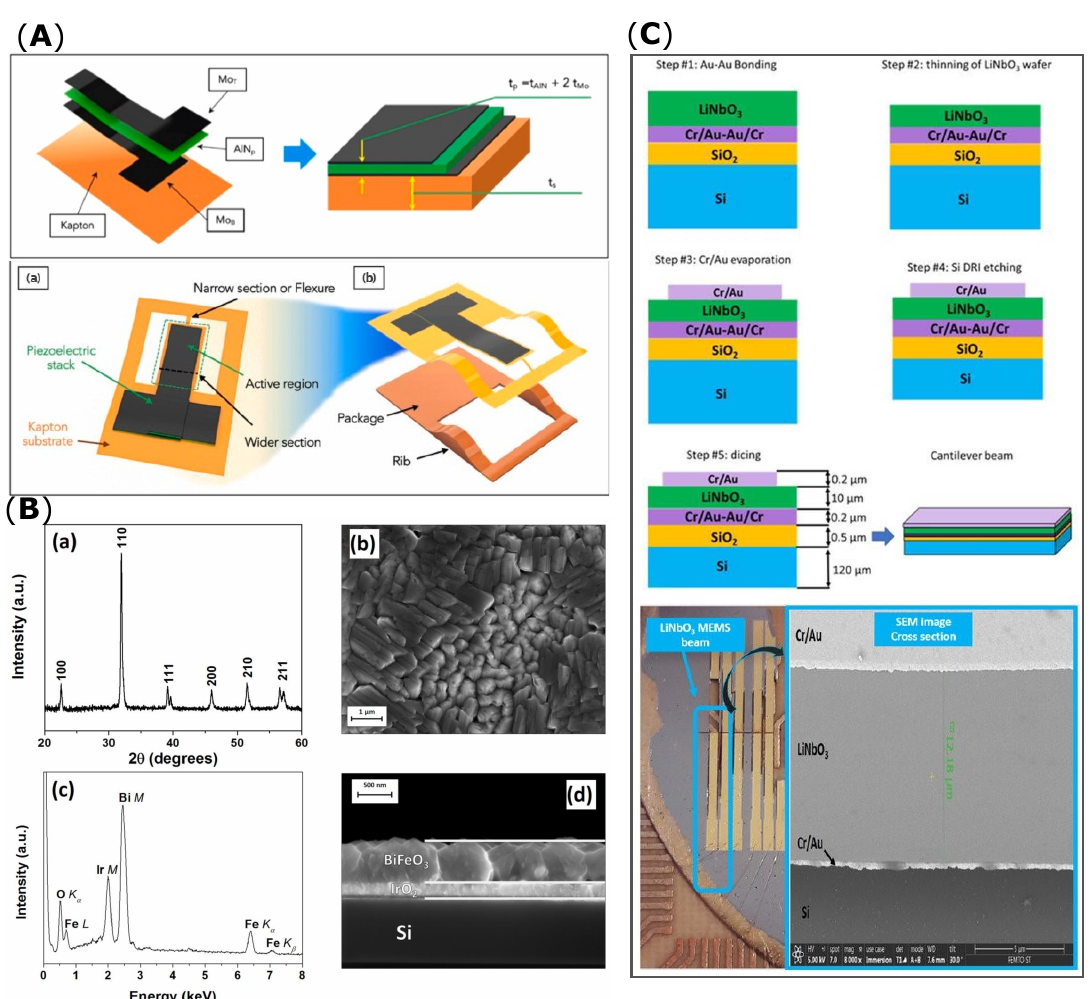
Figure 1. ( A ) AlN flexible piezoelectric transducer stacking sequence, and planar mechanism for harvesting application from [38]. ( B ) Characterization and optimization of BFO piezoelectric film on IrO 2 /Si substrate, panels show X-ray analysis and SEM images from [167]. ( C ) Fabrication flowchart of LiNbO 3 transducers on Si (Wafer-on-Wafer technology), MEMS cantilever top and cross-sectional view